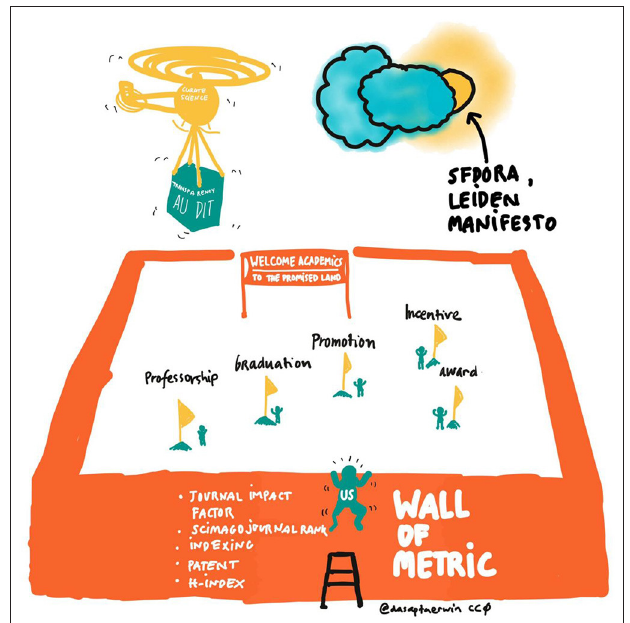
FIGURE 1 | Sketchnote the “Wall of Metric” by Dasapta Erwin Irawan to showcase the small playground of researchers/scientists that is filled with self-centered